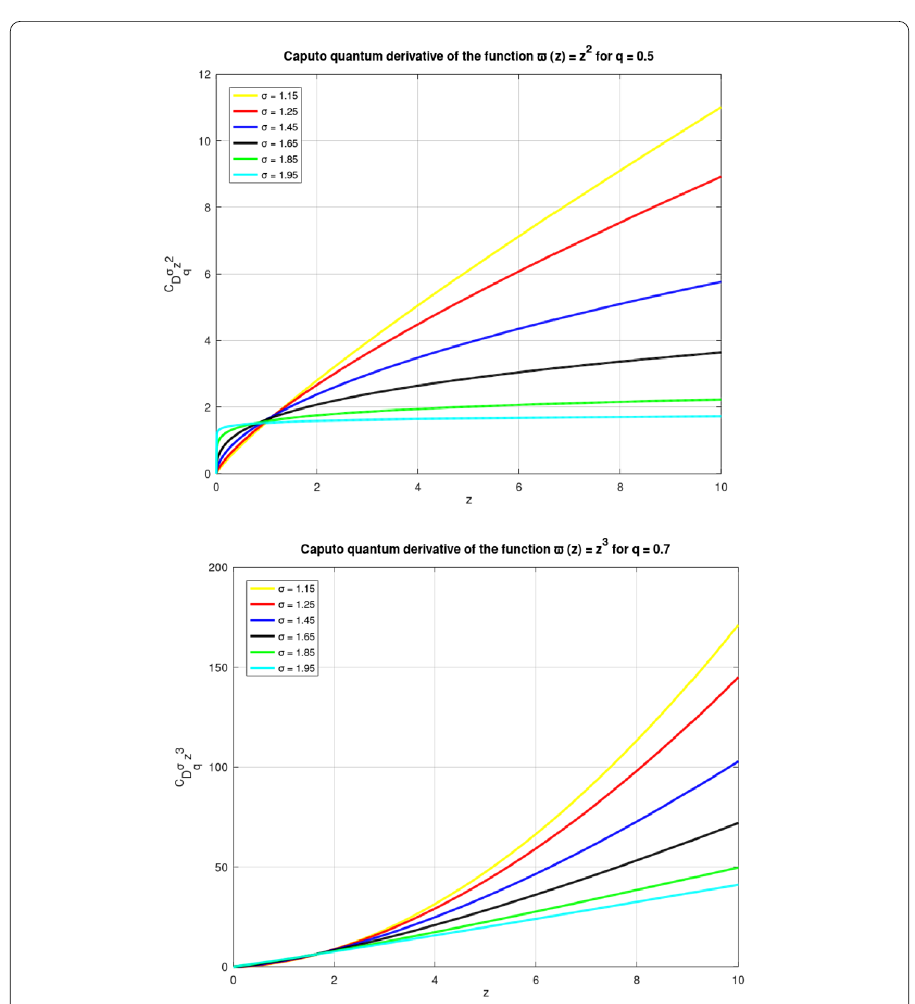
Figure 2 The Caputo quantum derivative of (cid:3) ( z ) = z 2 , z 3 for q =